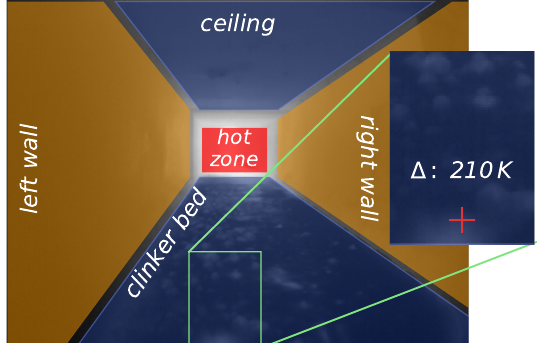
Figure 3. Main zones of the clinker cooler. The red cross marks point of maximum frame-to-frame temperature